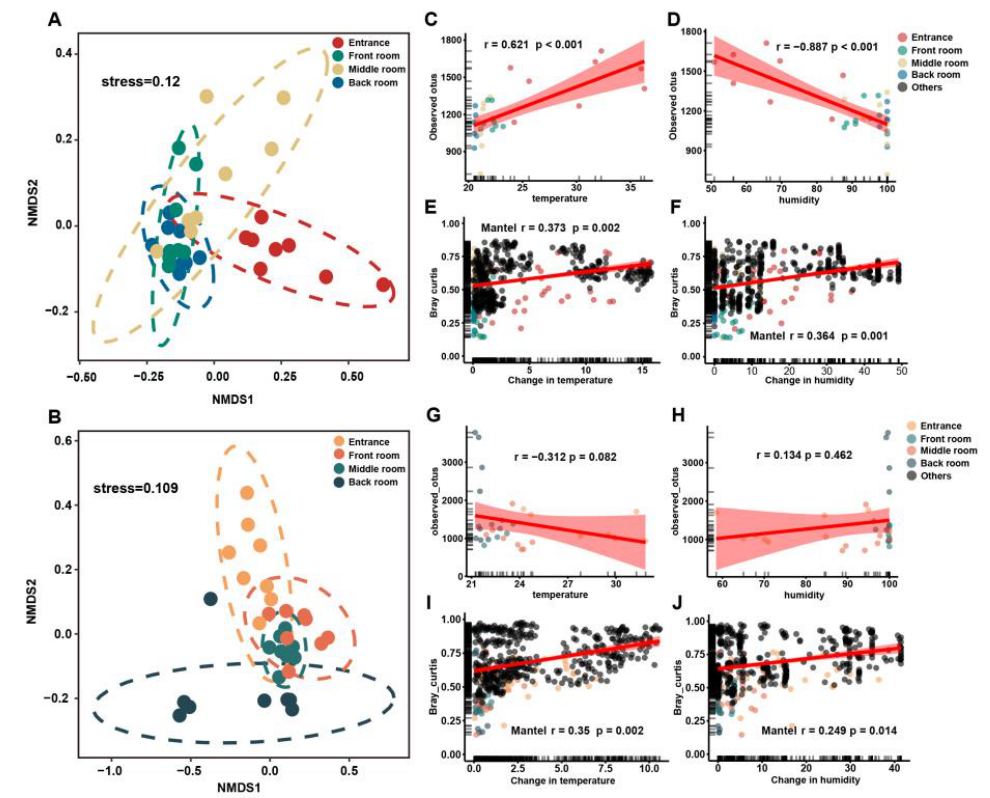
Figure 4. Nonmetric multidimensional scaling (NMDS) analysis of bacteria in Shunling ( A ) and Qinling Mausoleums ( B ) based on Bray–Curtis distance. Spearman Correlation analysis of observed OTUs with temperature and humidity in Shunling ( C , D ) and Qinling Mausoleums ( G , H ). Distance matrix regressions between Bray–Curtis and hydrothermal gradient in Shunling ( E , F ) and Qinling Mausoleums ( I , J ). Horizontal axes indicate Euclidean distances based on temperature and humidity. Linear relationships were evaluated by Mantel test ( p -value provided for each panel) ( E , F , I , J ). Linear models (shown as red lines) and associated correlation coefficients are provided for each